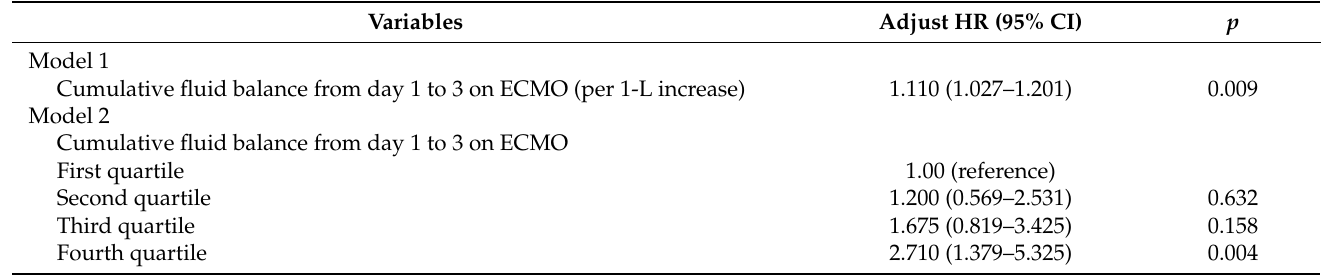
Table 4. Cox proportional hazard regression models with 90-day hospital mortality as